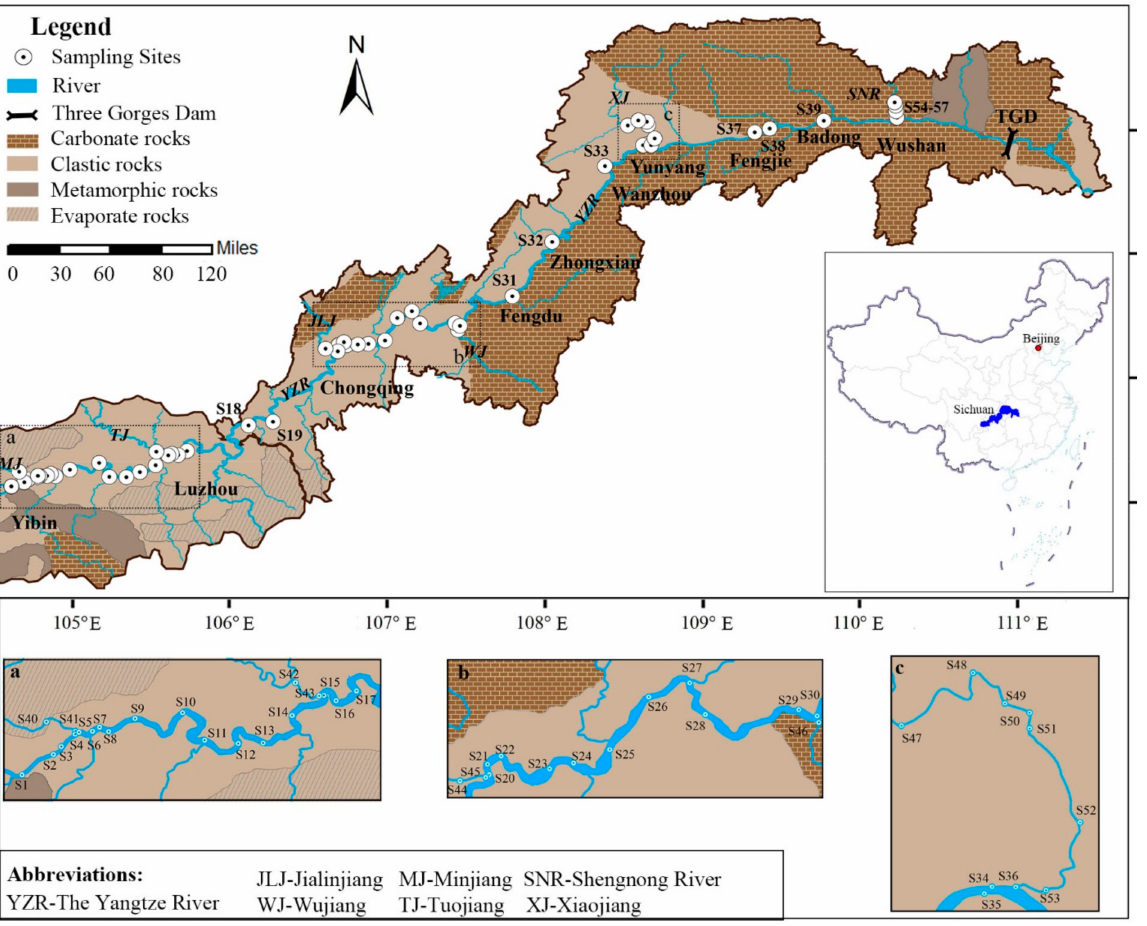
Figure 1. The lithology distribution and sampling sites of the upper TGR